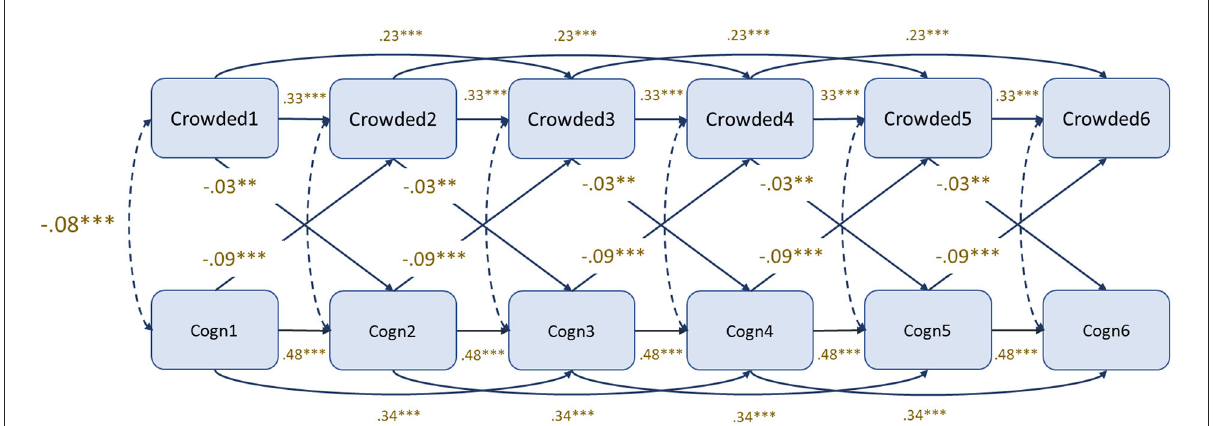
FIGURE1 Cognitive factors (“Response effectiveness of individual action” and “Self-efficacy with regard to avoiding people”) and behavior (crowded places). Cross-lagged panel model. Maximum likelihood robust estimator (MLR). χ 2 = 209.428; D.f. = 59; P < 0.001; RMSEA = 0.039 (0.033–0.044); CFI = 0.924; TIL =